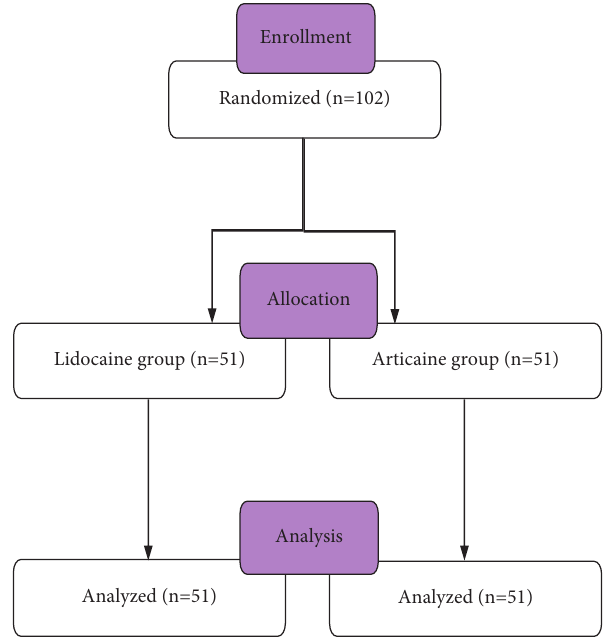
Figure 1: Flow diagram of the study